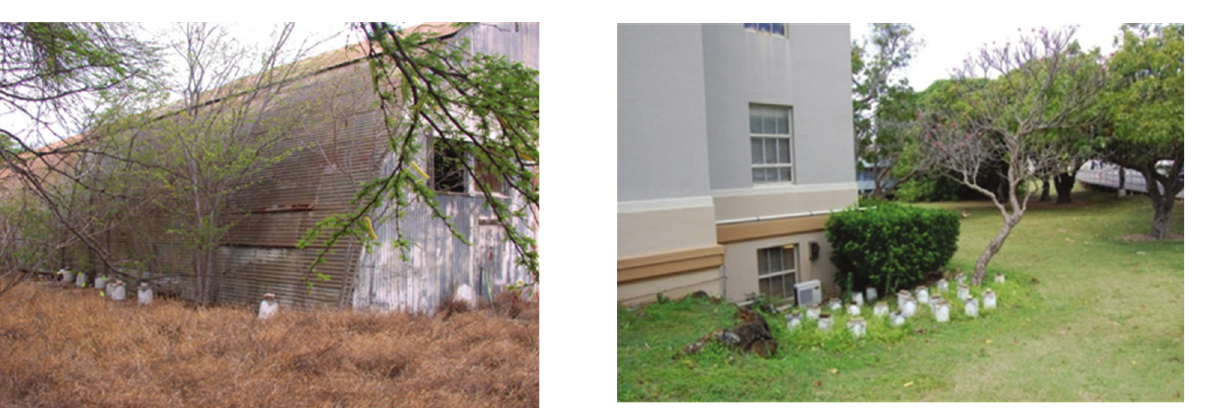
the lights beneath each arena and were allocated randomly to each species and wood treatment.